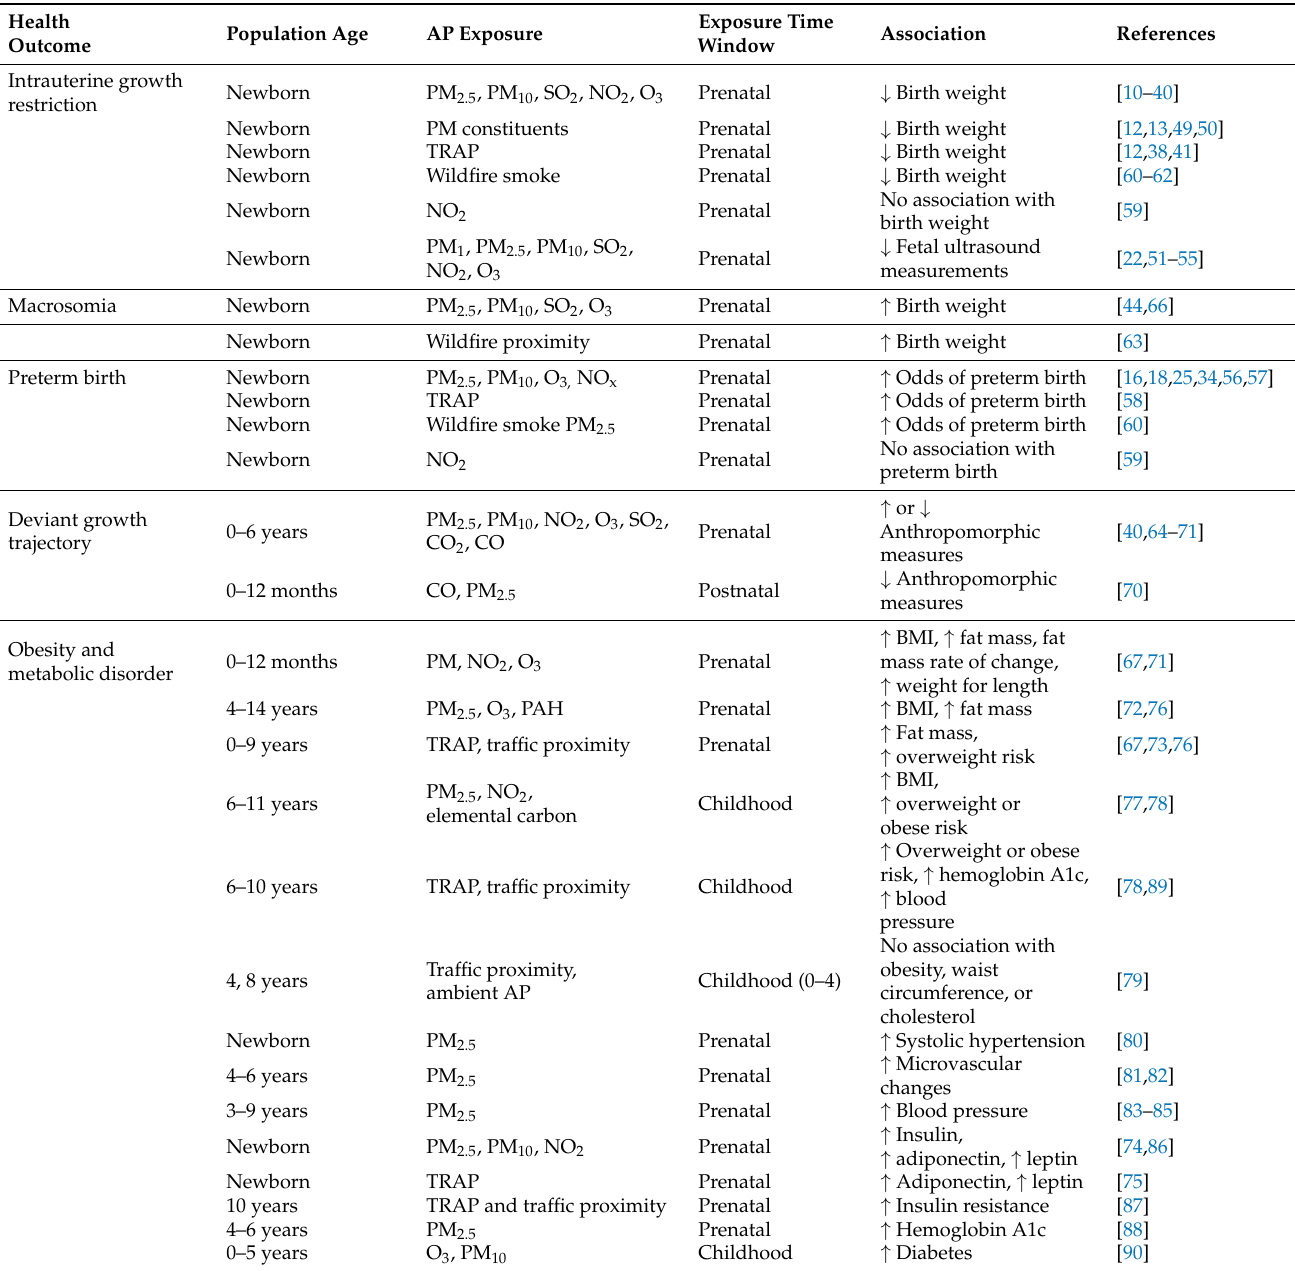
Table 1. Cardiovascular and Metabolic Outcomes Associated with Early-Life Air Pollution